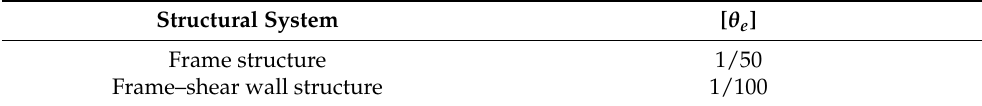
Table 9. Elastoplastic story drift limits for the